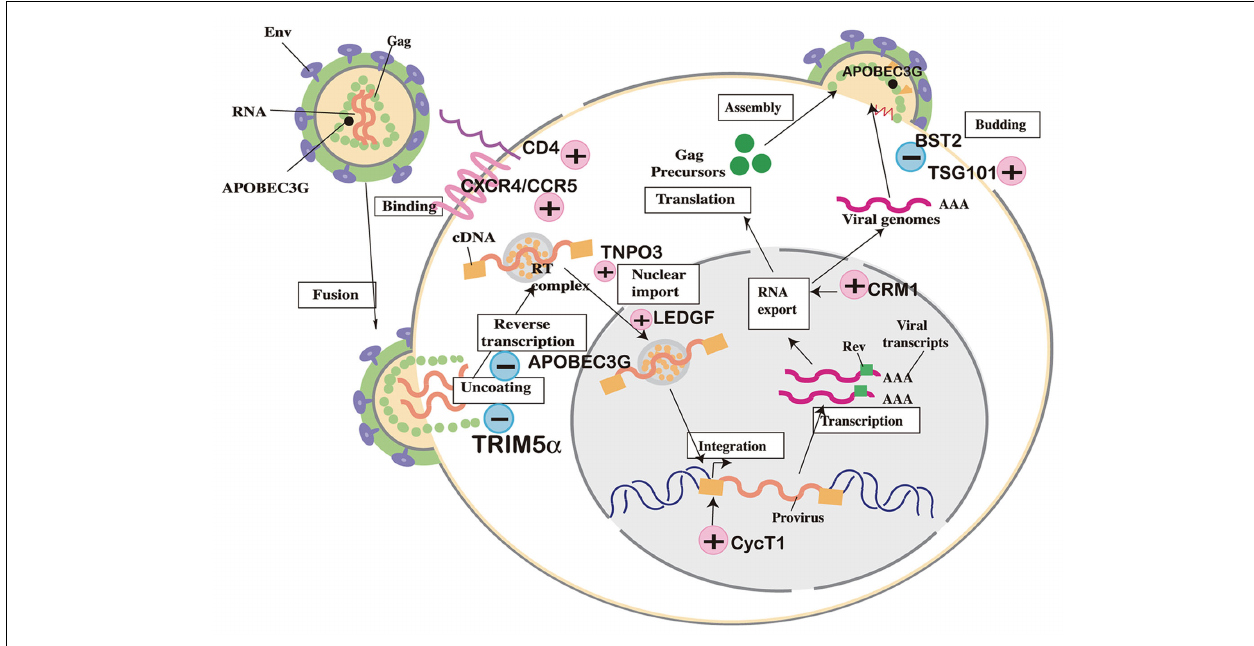
FIGURE 1 | Cellular factors involved in human immunodeficiency virus (HIV) replication cycle. ( + ) Positive factors required for viral replication. ( − ) Negative factors that suppress viral